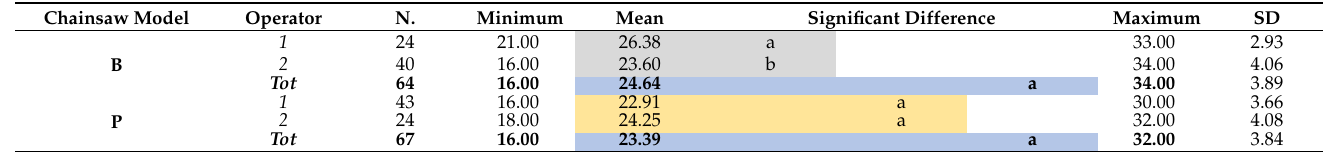
Table 3. Diameter dimensions (cm) of the cut trees, showing mean, maximum, minimum, and SD (1 and 2). Different lowercase letters show the presence of a significant difference ( p value <